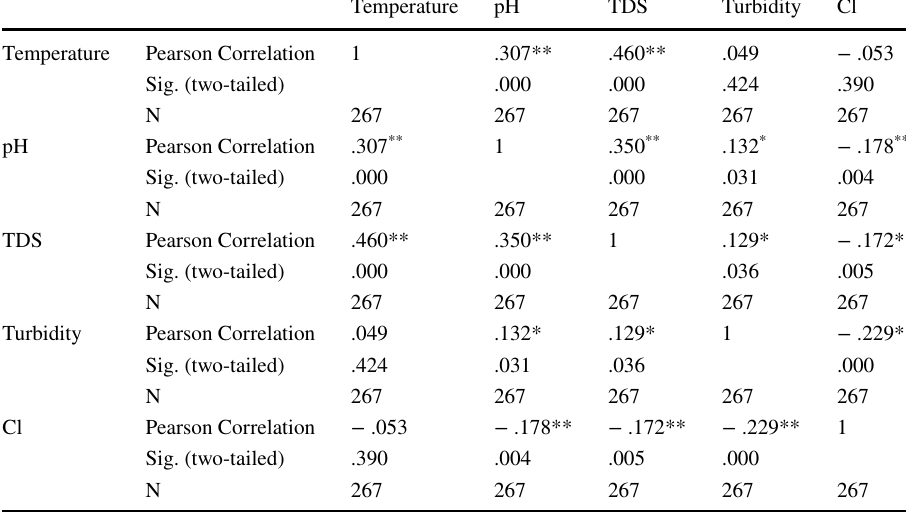
**Correlation is significant at the 0.01 level (two-tailed) *Correlation is significant at the 0.05